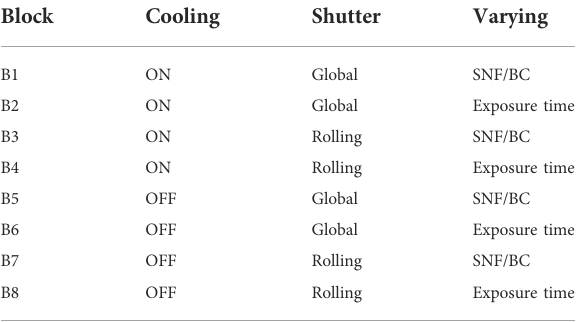
TABLE 2 Summary of camera data division for Spurious Noise Filter and Blemish Correction